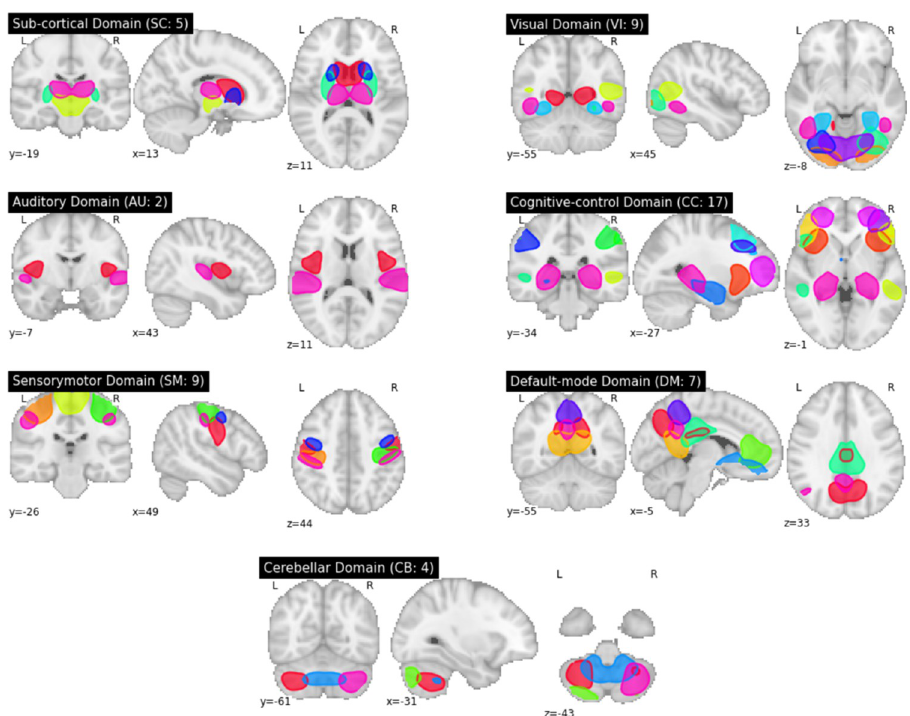
Fig 1. Group ICA-derived spatial maps. Spatial maps are grouped into seven domains, subcortical (SC), auditory (AU), sensory-motor (SM), visual (VI), cognitive control (CC), default mode (DM), and cerebellar (CB), each of which contains 5, 2, 9, 9, 17, 7, and 4 networks,